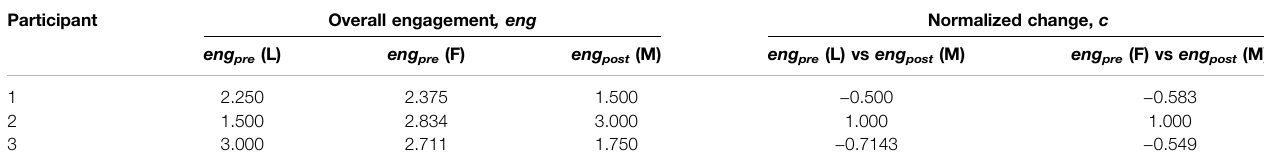
TABLE 4 | Overall engagement values and normalized engagement changes for the three participants, with the robot in a single role versus mixed roles (L: Leader, F: Follower, M: Mixed). A gain in engagement occurs only for Participant 2. Participant Overall engagement ,